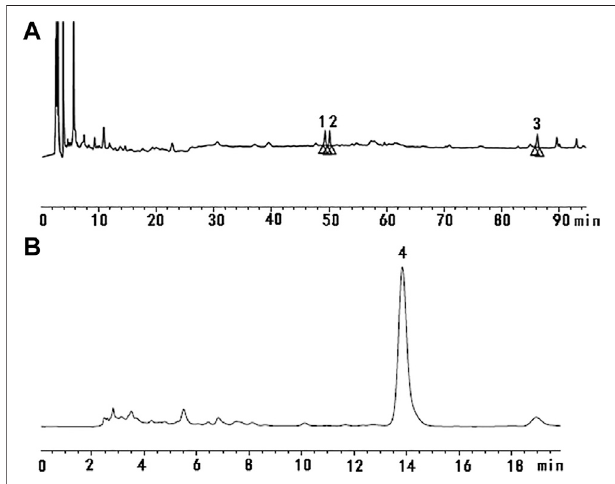
FIGURE1| Representativechromatogramoftheprimarycompoundsin JDTLG: (A) 1. Ginsenoside Rg1, 2. Ginsenoside Re, 3. Ginsenoside Rb1; (B) 4. Baicalin.